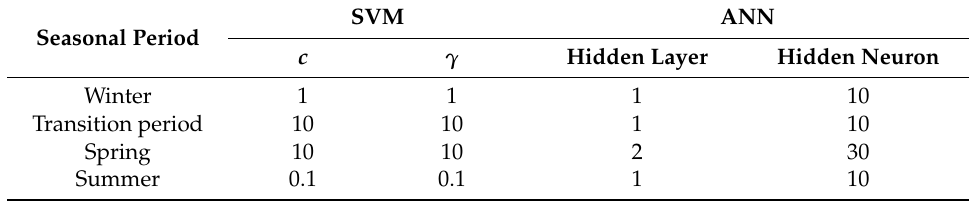
Table 6. Selection Results of parameter tuning of classification algorithms.